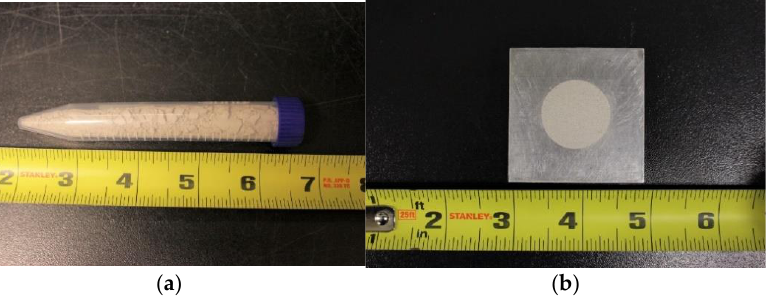
Figure 5. The Lac du Bonnet granite sample. ( a ) Sample with grain size less than 75 μm. ( b ) Sample prepared for XRD